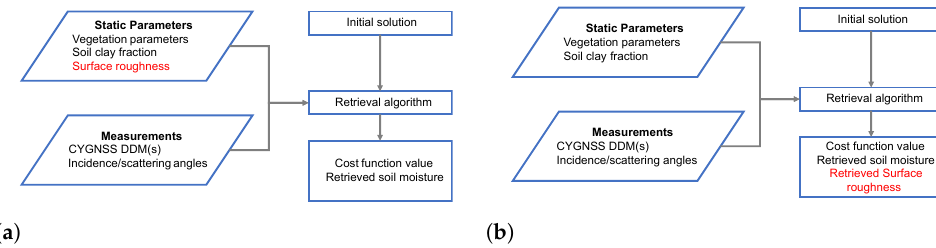
Figure 3. Soil moisture retrieval algorithm. The red texts highlight the differences between the two schemes. ( a ) First retrieval scheme: only retrieve soil moisture. ( b ) Second retrieval scheme: retrieve both soil moisture and surface roughness.